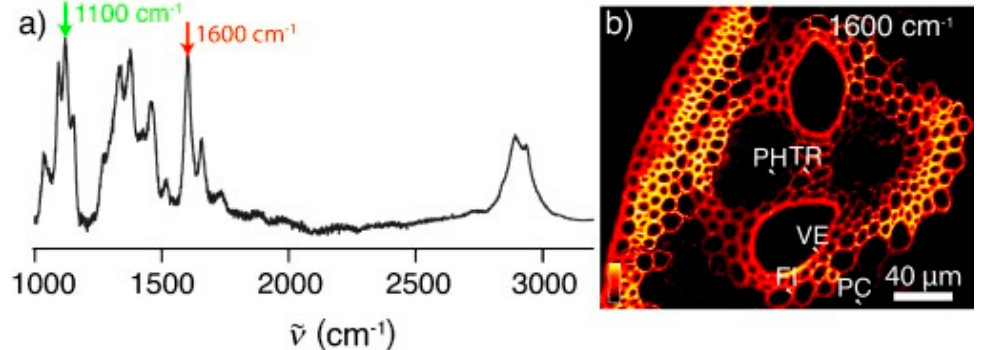
Figure 5. Raman images of xylem for poplar wood calculated by integrating from 2800 to 3030 cm − 1 ( a , b overall morphology), from 2800 to 2918 cm − 1 ( c , d carbohydrates), from 1540 to 1700 cm − 1 ( e , f , lignin), from 1255 to 1290 cm − 1 ( g , h G units), and from 1320 to 1338 cm − 1 ( i , j , S units). Images a , c , e , g , i : xylem near the cambium and images b , d , f , h , j xylem near the annual ring (AR). Reproduced with permission from Ref. [59]. Copyright SPRINGER NATURE 2018.